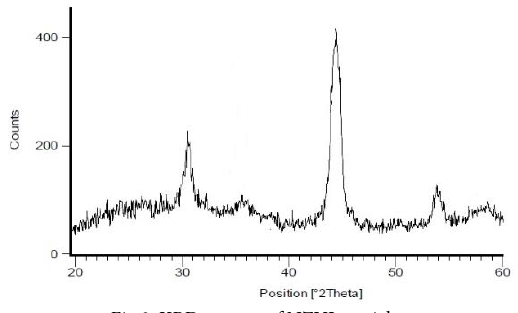
Fig 2. SEM image of synthesized iron nanoparticles. Fig 3. XRD pattern of NZVI